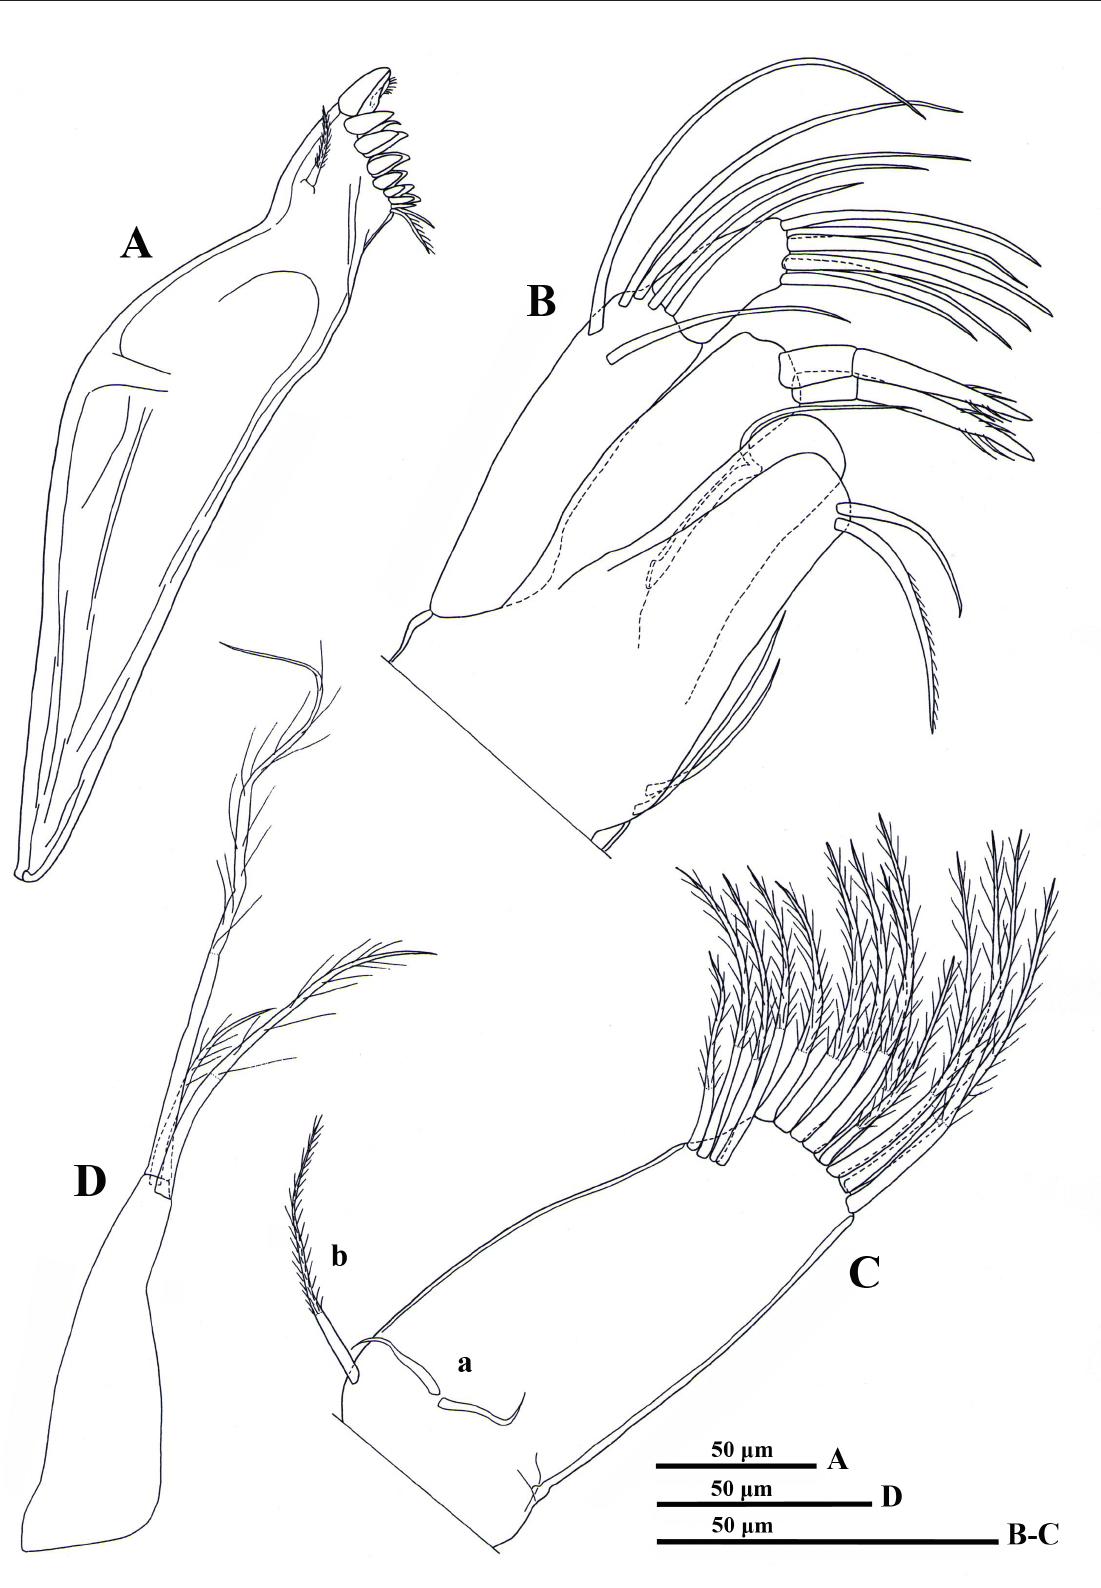
Fig. 4. Pseudostrandesia ratchaburiensis sp. nov. Paratype, ♀ (MSU-ZOC. 292). A . Md-coxa. B . Mx1. C . A part of basal protopod with medial endite of T1. D .